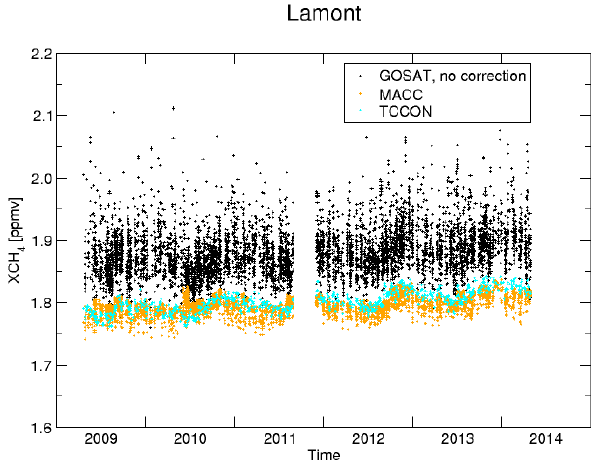
Figure 4. Average of the relative total methane column with respect to TCCON measurements for GOSAT-TIR retrievals (black) and the (non-scaled) MACC prior (orange). The bars indicate the spread in the data